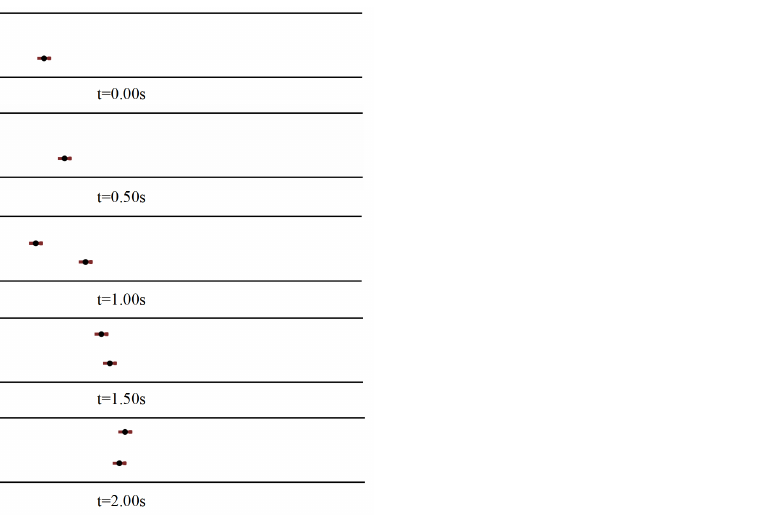
Figure 9. The simulation diagram of each moment of the bicycle overtaking the bicycle.